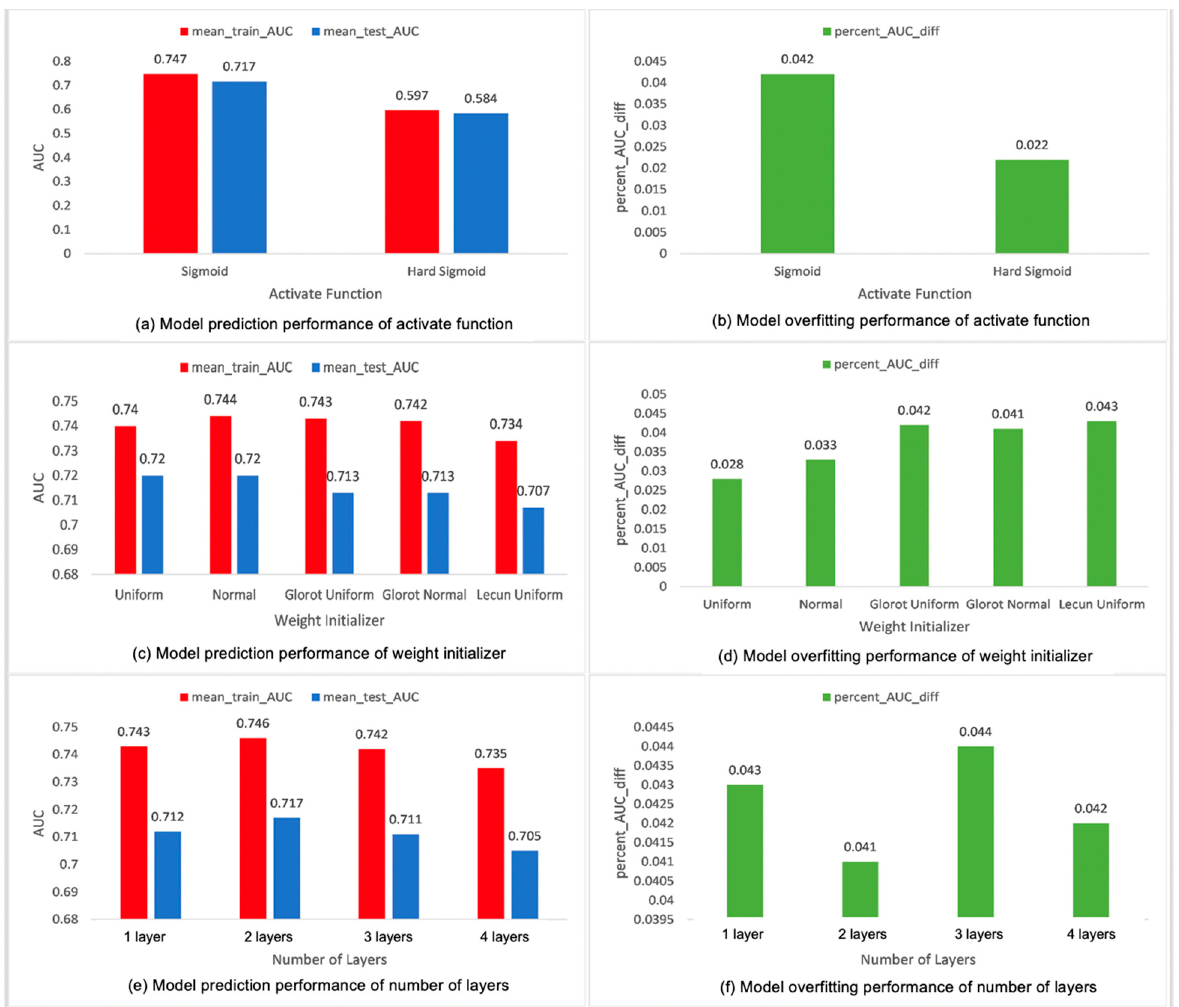
Figure 4. Average mean_train_AUC, mean_test_AUC, and percent_AUC_diff for activation function, weight initializer, and number of layers.